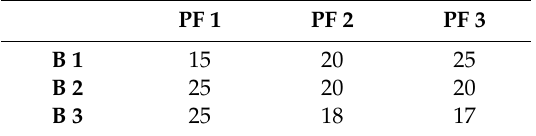
Table A1. Distance between Biomass Sources and Pretreatment Facilities in km.